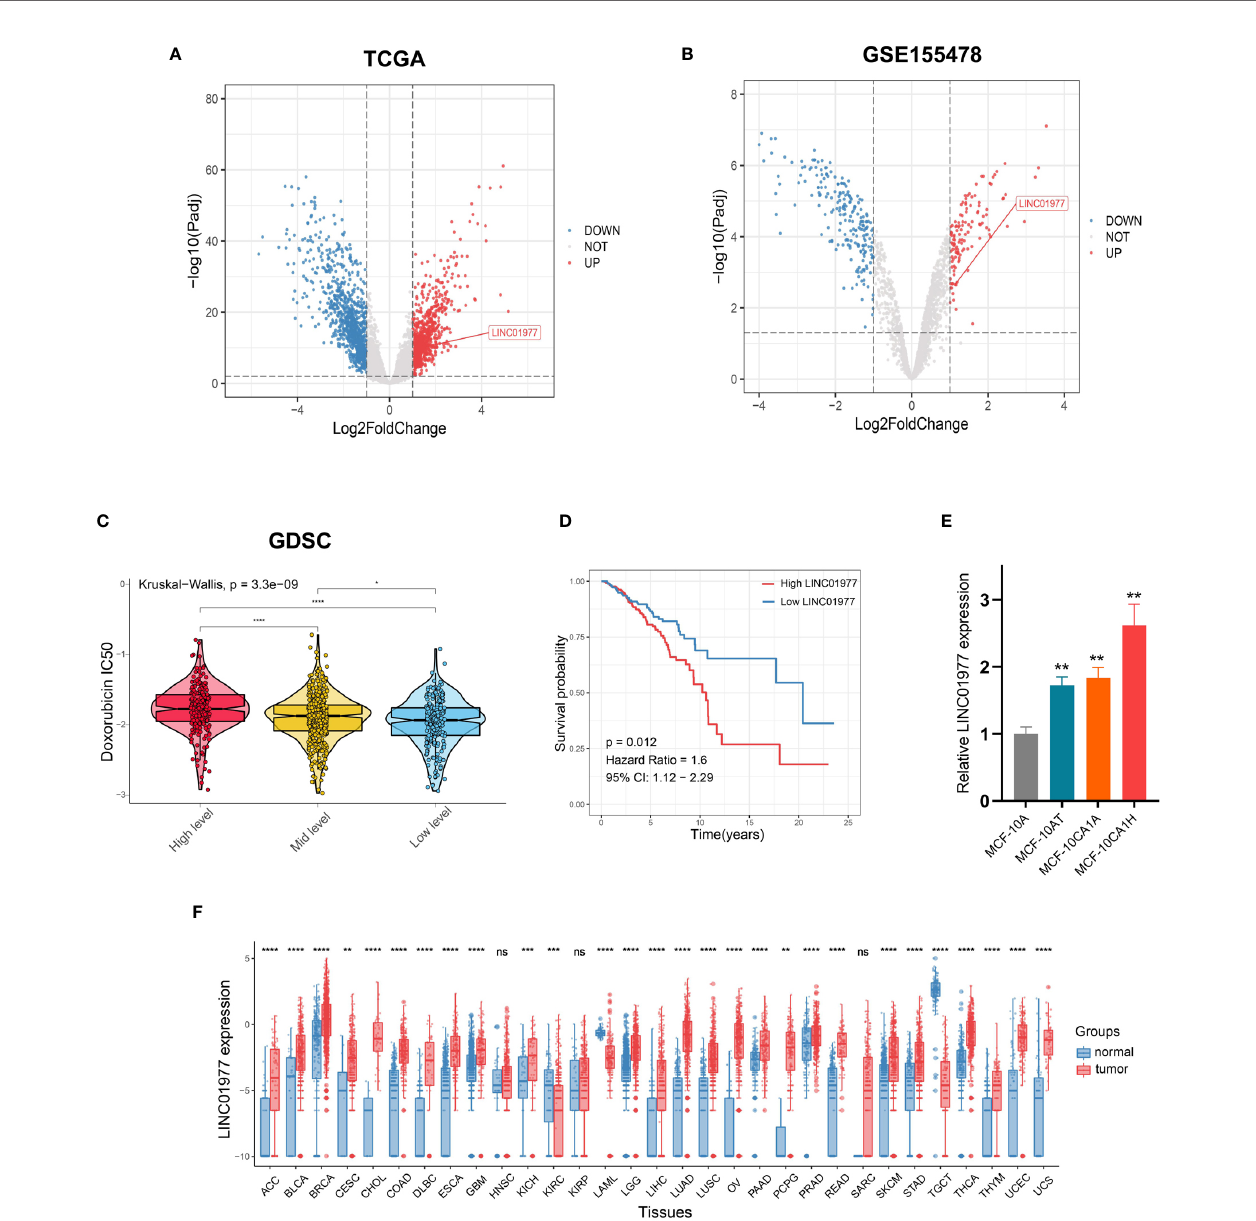
FIGURE 1 | LINC01977 functioned as an oncogenic driver and predicted a poor prognosis in breast cancer patients. (A) Different analysis between 112 tumors and paired normal samples from TCGA breast cancer data. (B) Different analysis between DOX sensitive and resistant cell lines from GSE155478. (C) IC50 value for DOX of TCGA breast cancer patients was estimated on the basis of GDSC drug response data. Three subgroups represented the expression level of LINC01977. (D) Kaplan-Meier survival analysis in TCGA breast cancer patients. (E) Expression pro fi les of LINC01977 in breast cancer progression cell line model. (F) Expression pro fi les of LINC01977 in pancancer dataset. (*p < 0.05, **p < 0.01, ***p < 0.001, ****p < 0.0001; Student ’ s